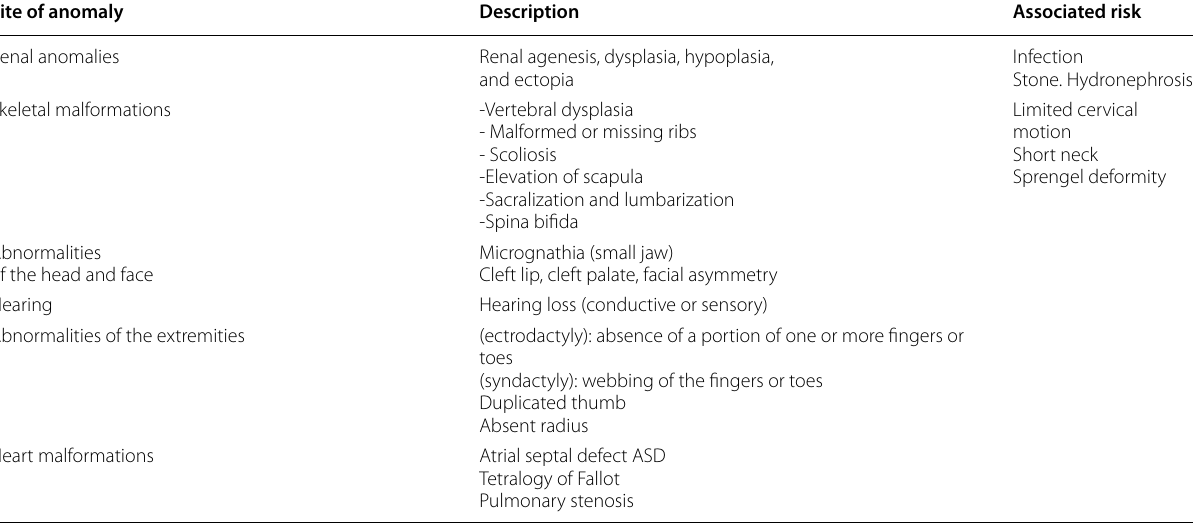
Table 2 Anomalies associated with type II MRKHS a